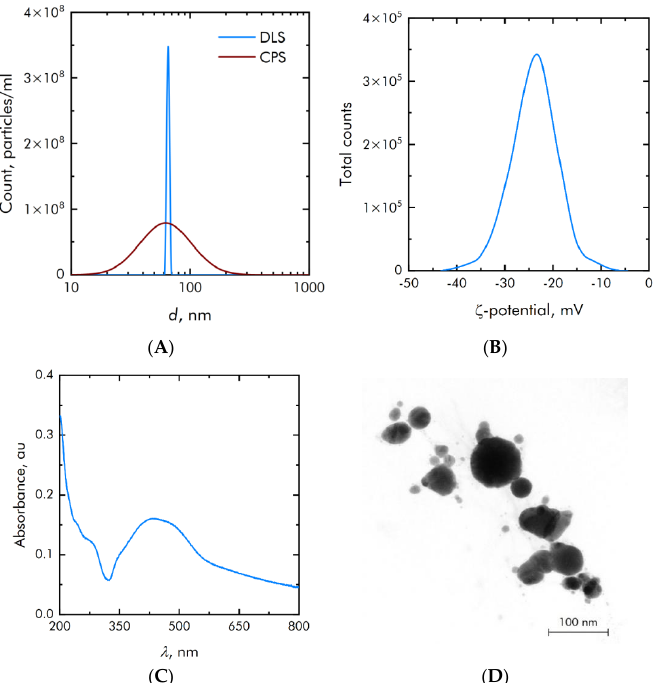
Figure 2. Physicochemical characterization of silver oxide NPs. ( A ) — Concentration (DLS) and size (CPS) distribution of silver oxide NPs. ( B ) — Zeta potential distribution of synthesized silver oxide NPs. ( C ) — Optical absorption spectrum of silver oxide NPs colloid. ( D ) — TEM microphotography (CPS) distribution of silver oxide NPs. ( B )—Zeta potential distribution of synthesized silver oxide silver oxide NPs. NPs. ( C )—Optical absorption spectrum of silver oxide NPs colloid. ( D )—TEM microphotography silver oxide